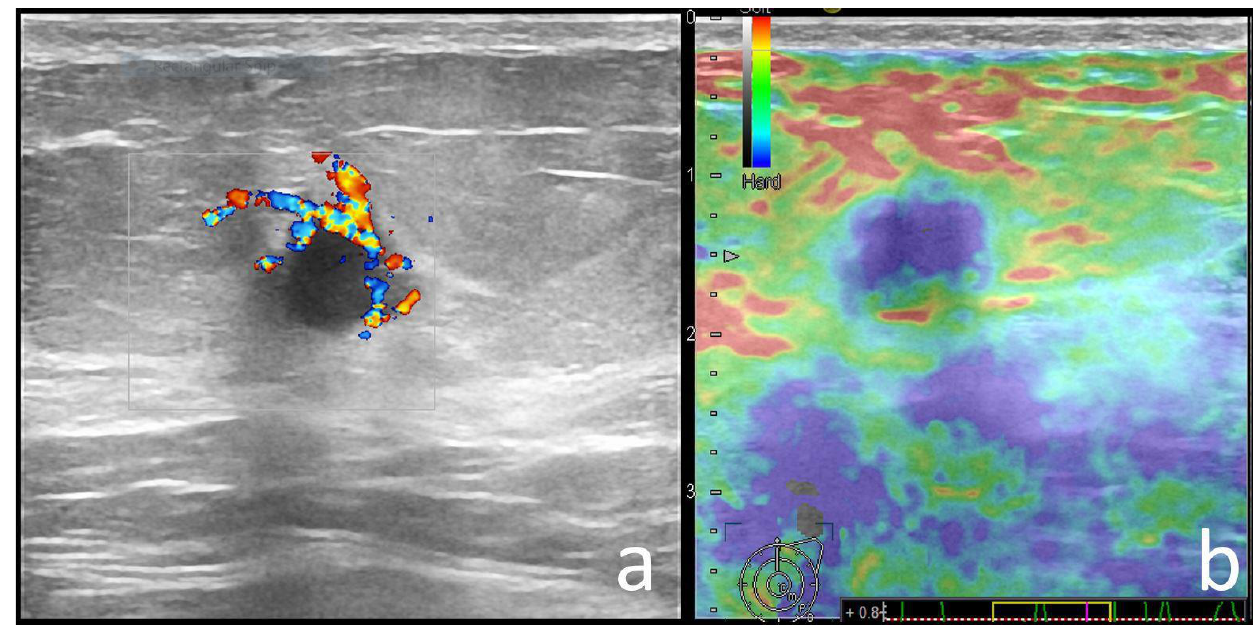
Figure 6. 53-year-old BRCA1 mutation carrier patient with left breast cancer. There is a round, circumscribed, hypoechoic mass, with periphery vessels ( a ) and a blue-green-red elastography appearance ( b ). Pathology: IDC-NST, ER/PR/HER2-negative, grade 3, ki67 = 90%. Axillary US was positive in 37 out of 98 pathogenic mutation carriers and 77 out of 145 negative patients. For the carrier group, the positive axillary US cases corresponding to positive axillary surgery reached a moderate agreement (kappa = 0.48, p = 0.000). For the mutation-negative group, US corresponding to surgery reached a substantial agree- ment (kappa = 0.656, p < 0.0001) in depicting axillary lymph node involvement (Table 2) . Table 2. Breast cancer US features in carrier and non-carrier patients.